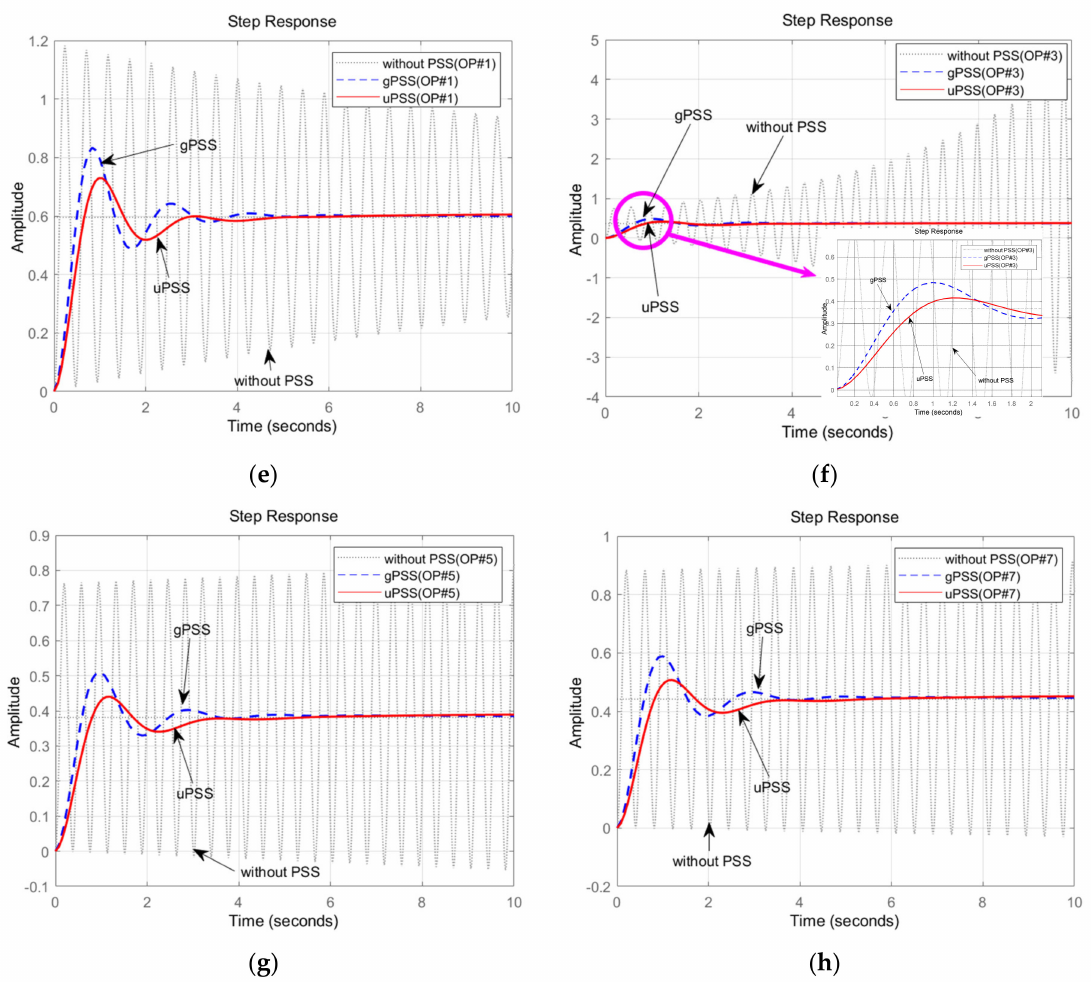
Figure 10. Step response in the SMNB model: ( a ) step size 0.3 in operating point #1, ( b ) step size 0.3 in operating point #3, ( c ) step size 0.3 in operating point #5, ( d ) step size 0.3 in operating point #7, ( e ) step size 0.6 in operating point #1, ( f ) step size 0.6 in operating point #3, ( g ) step size 0.6 in operating point #5, and ( h ) step size 0.6 in operating point